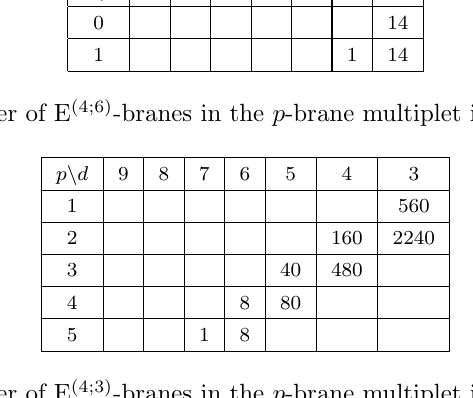
Table 28 . Number of E (4;3) -branes in the p -brane multiplet in d -dimensions [17]. p \ d